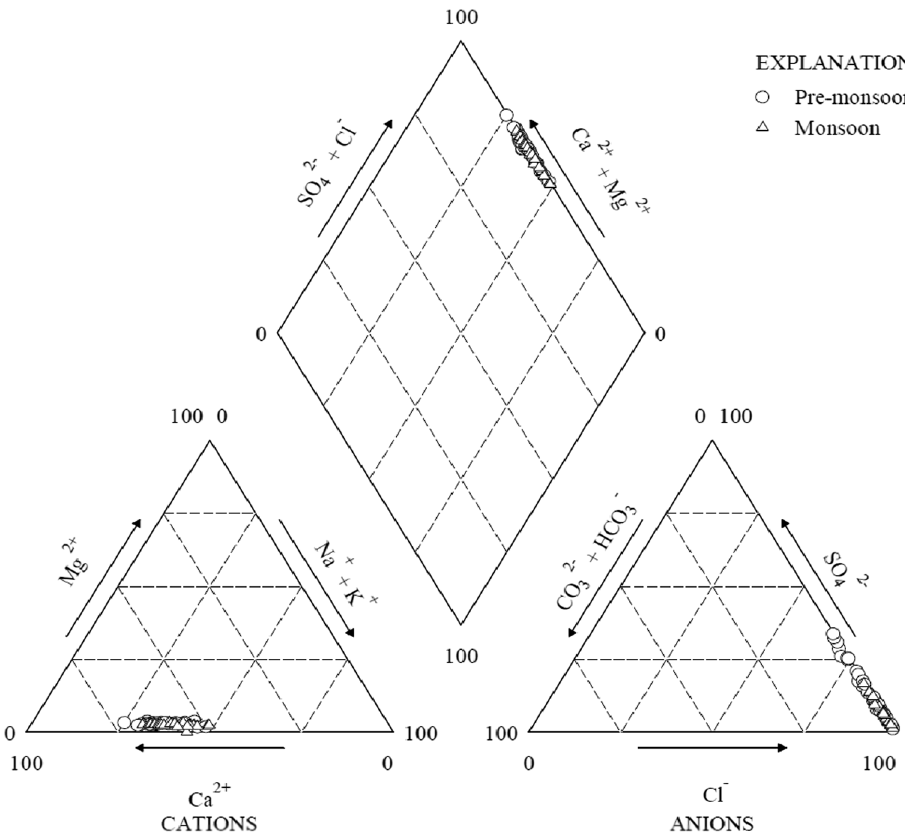
Fig. 6 Piper diagram of ground- water samples during pre-mon- soon and monsoon